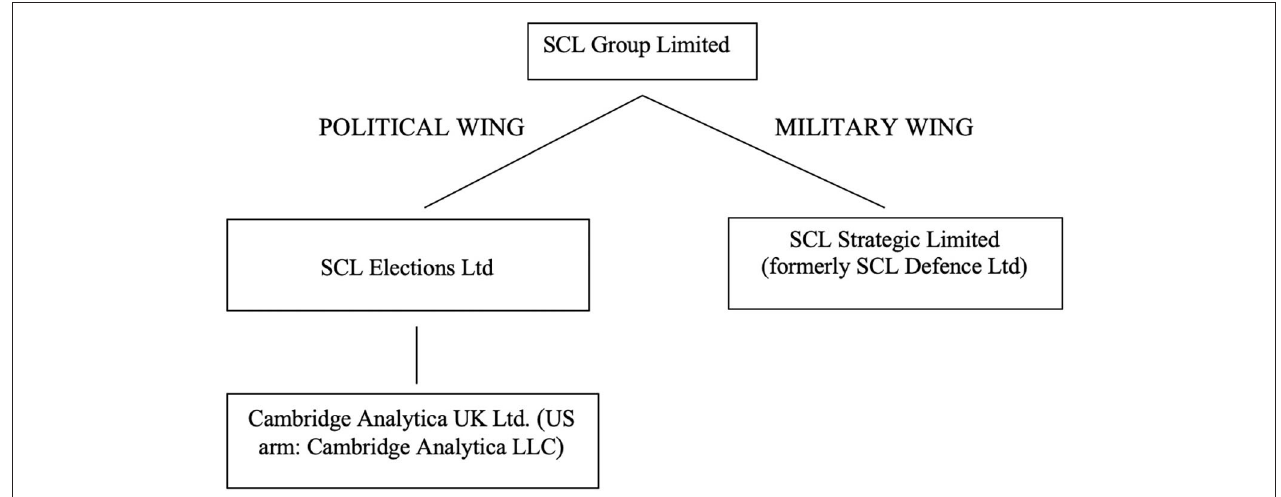
FIGURE 1 | Corporate structure of SCL Group Ltd and